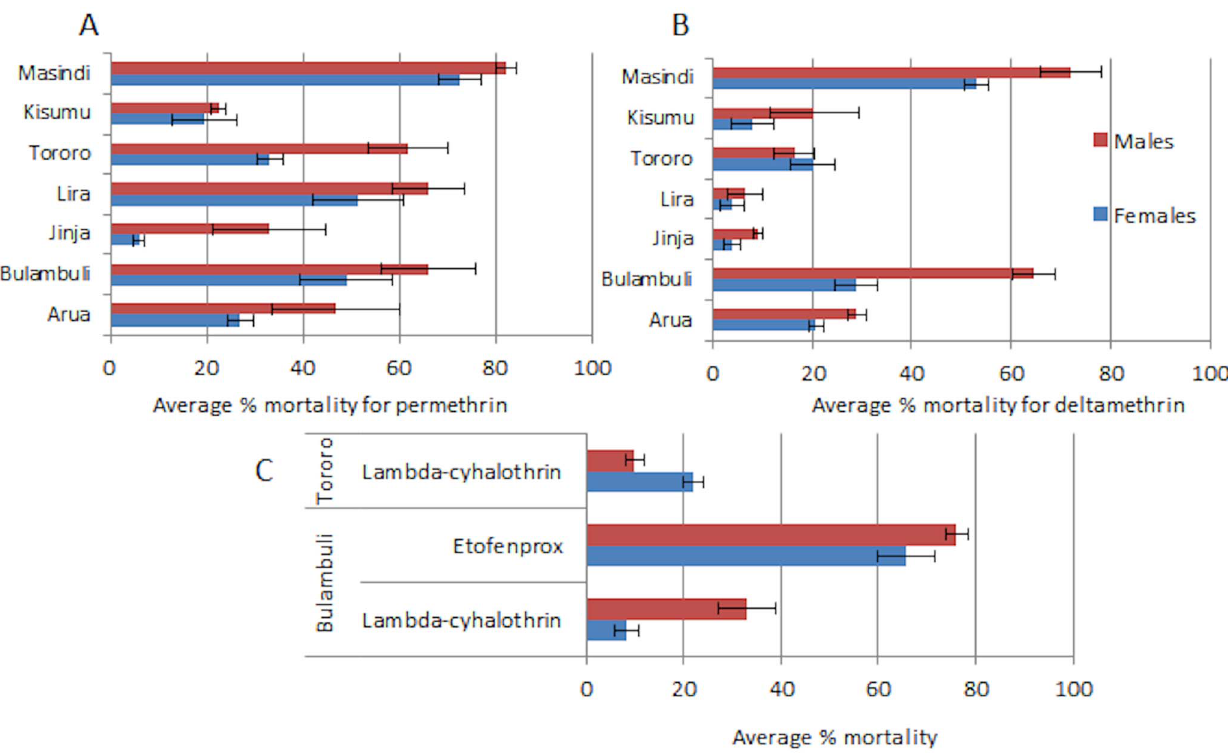
Figure 2. Resistance profiles for pyrethroids in An.funestus populations Uganda and Kenya (Kisumu). (A) is for permethrin and (B) for deltamethrin.